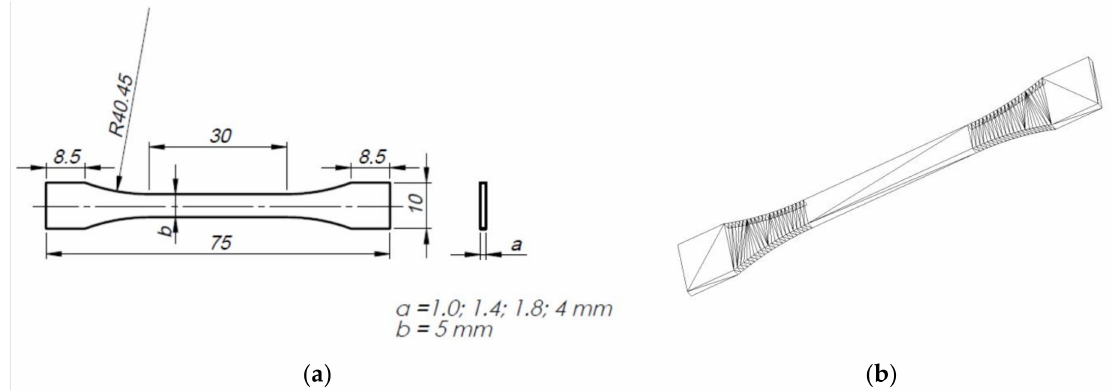
Figure 1. Tensile specimen, ( a ) 2D diagram with dimensions, ( b ) 3D sketch with a grid converted to triangles saved an . stl